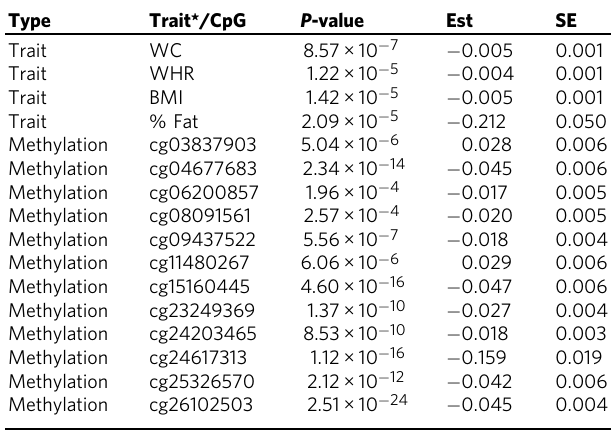
Table 5 Signi fi cant POE from cis -POE – mQTL rs6100212